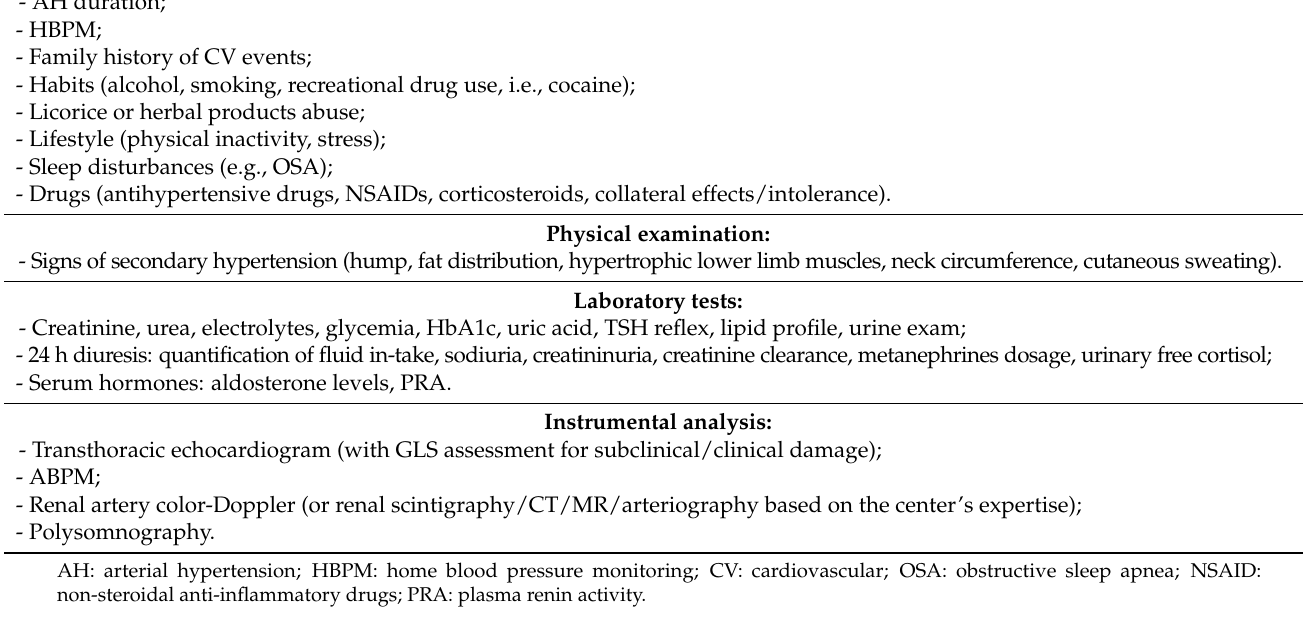
Figure 1. Approach to arterial hypertension therapy in patients treated with cardiovascular toxic therapy. BP: blood pressure, ABPM: ambulatory blood pressure monitoring, ACEi: angiotensin converting enzyme inhibitors, RAAS: renin-angiotensin-aldosterone system. Table 4. Principles of evaluation of patients with resistant arterial hypertension. Patient